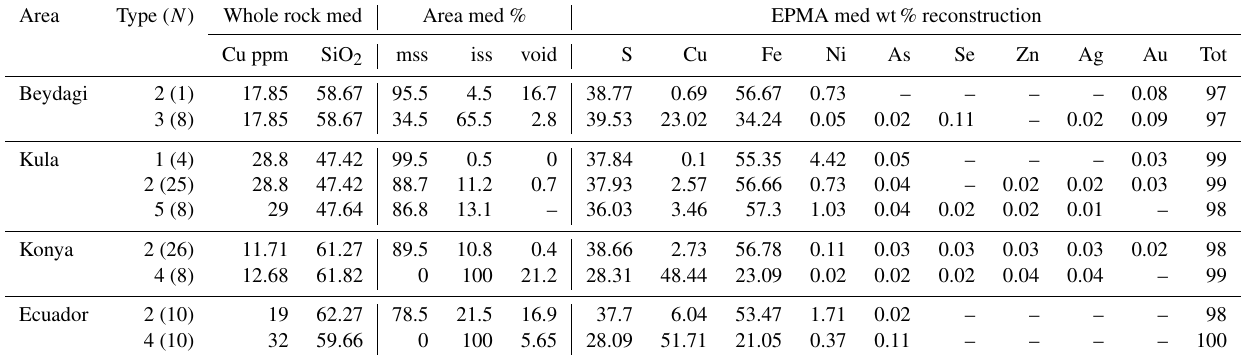
Table 2. Summary composition of 100 reconstructed sulfides belonging to different sulfide types ( N is the number of sulfides reconstructed) observed in every study area except Itecektepe and Elmadag where the Cu-rich phase was too small to analyse with the EPMA. The empty cells (–) correspond to a lack of measurement either because it was below the determination limit or not measured, and the term med accounts for the median (wt%) values. For the complete dataset (including mss/iss area% of Itecektepe and Elmadag), see Table 5 at